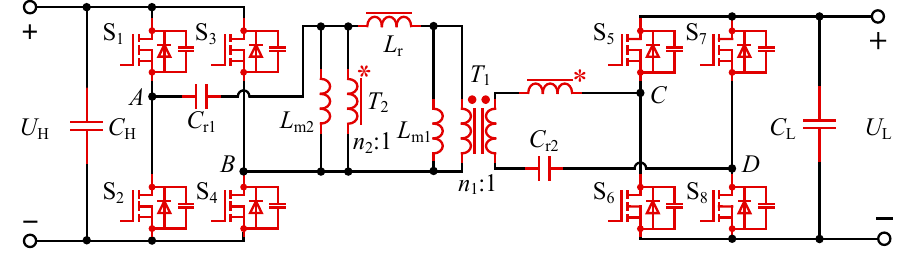
Figure 1. The proposed bidirectional CLTC multi-resonant DC-DC converter.